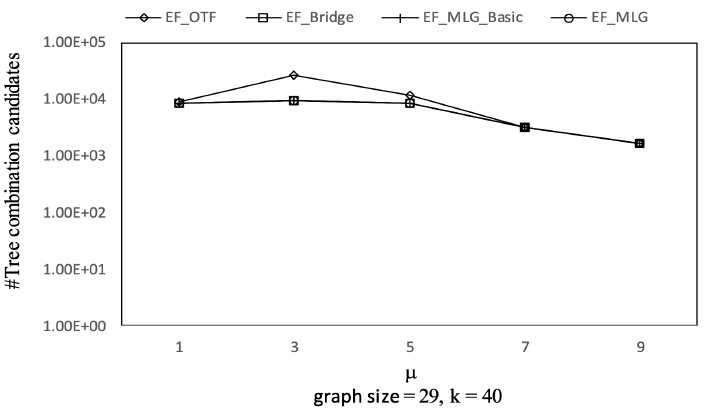
Figure 25. Tree combination pruning on Ncfu vs. µ with graphsize = 29 and k = 40.